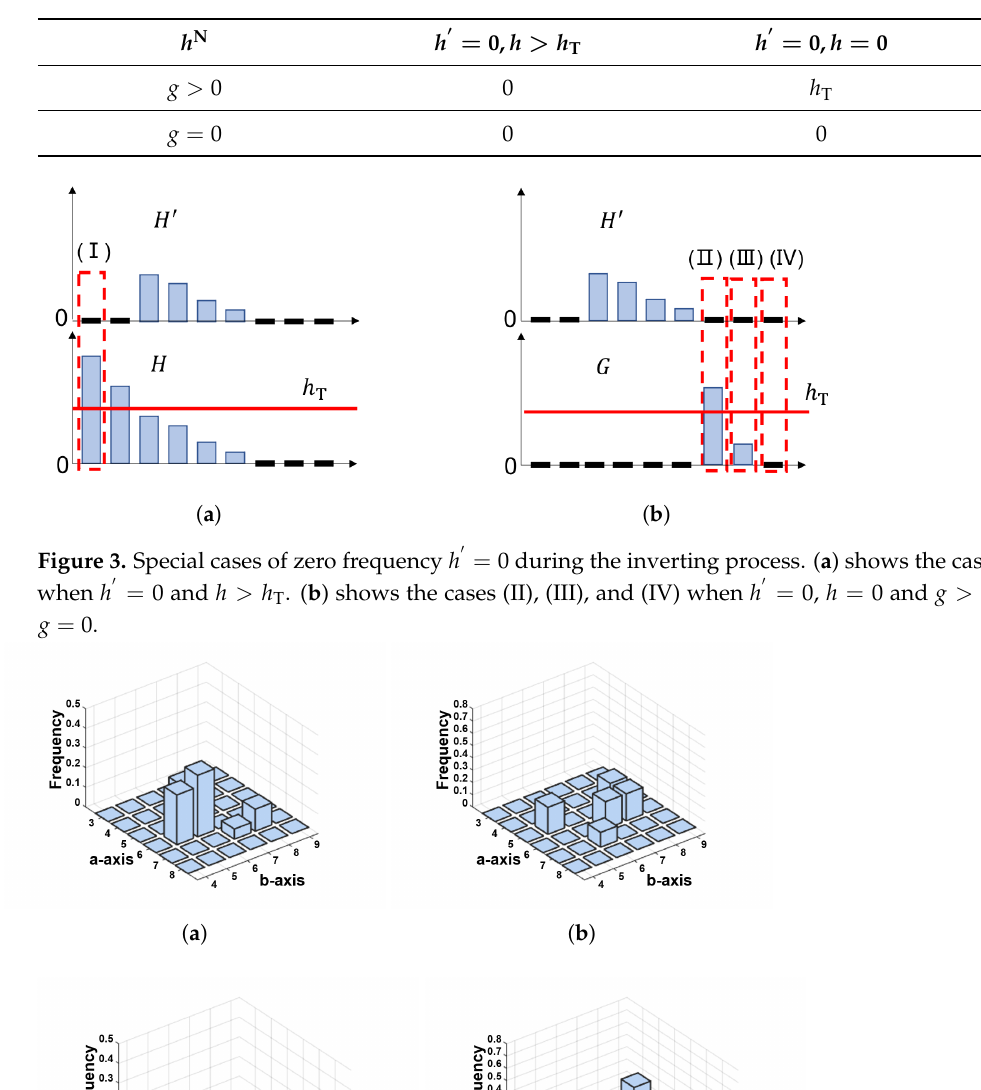
Table 2. Value of h N in conditions of h (cid:48) = 0.